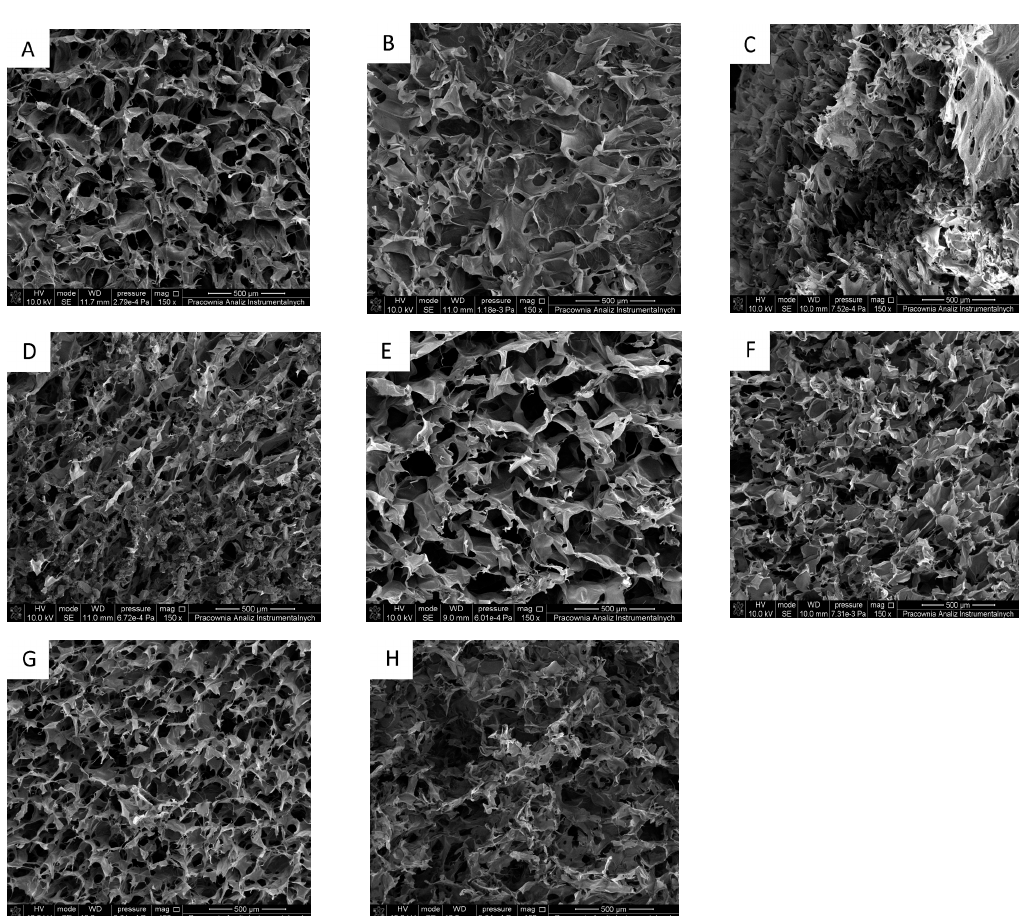
Figure 3. Scanning electron microscopy (SEM) images of CTS/Coll (fish) ( A – D ): ( A ) Without melatonin, ( B ) +0.001 g melatonin, ( C ) +0.01 g melatonin, ( D ) +0.1 g melatonin; and CTS/Coll (rat) ( E – H ): ( E ) Without melatonin, ( F ) +0.001 g melatonin, ( G ) +0.01 g melatonin, ( H ) +0.1 g melatonin.